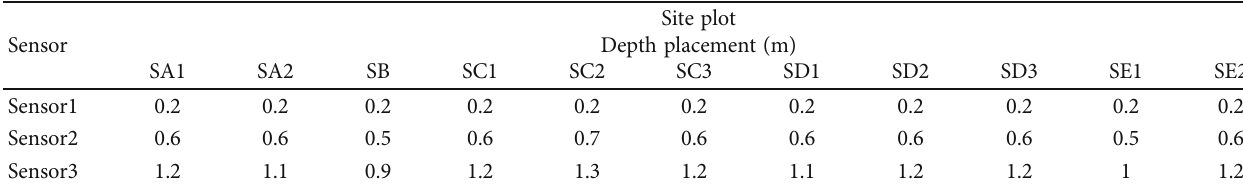
Figure 6: The block diagram and tool set of monitoring equipment: (a) block diagram, (b) sensor node box, (c) inside box, and (d) rain gauge with a digital display. Table 1: In-ground depth placement of sensors.